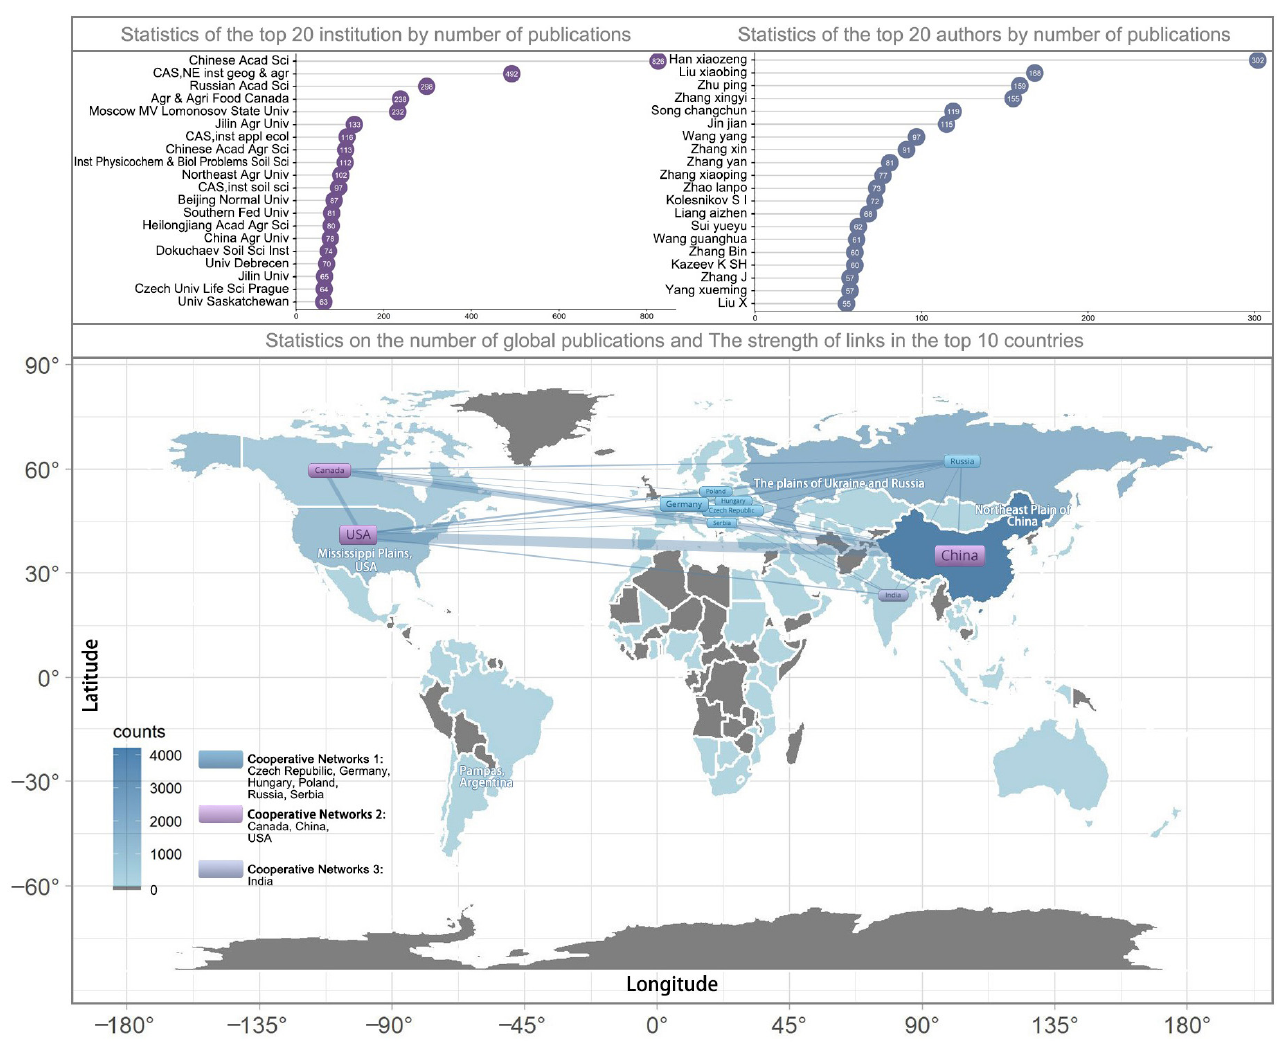
Figure 5. Relevant institutions, core authors, and the number of articles published globally, January 2000 to September 2021. Summary of the top 20 institutions and top 20 authors by the number of publications. Summary of the number of global publications and the significant links in the top 10 countries.